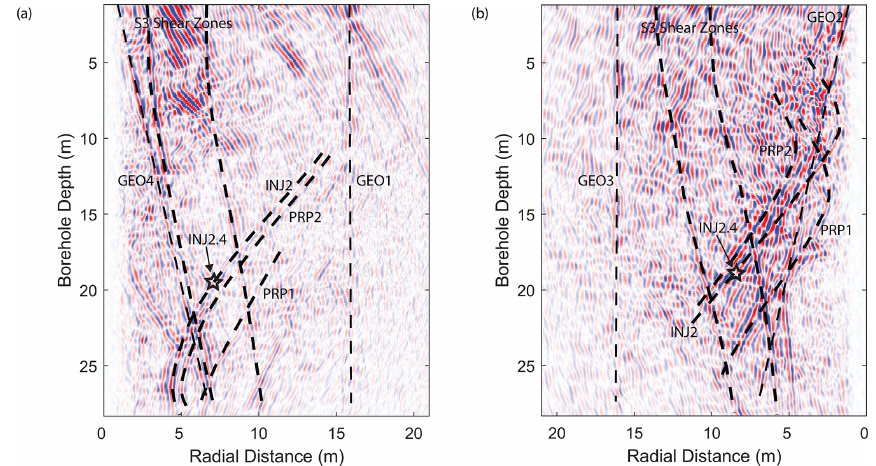
Figure 5. Reference profiles for the reflection GPR surveys. (a) Reference from GEO3. (b) Reference from GEO1. Important reflections are indicated by dashed lines and the injection location is marked with a star. Note that the x axis with the distance from the borehole has an opposite direction on the two profiles, such that the geometry is comparable. However, the reflections are not necessarily in the GEO1–GEO3 borehole plane due to the radial